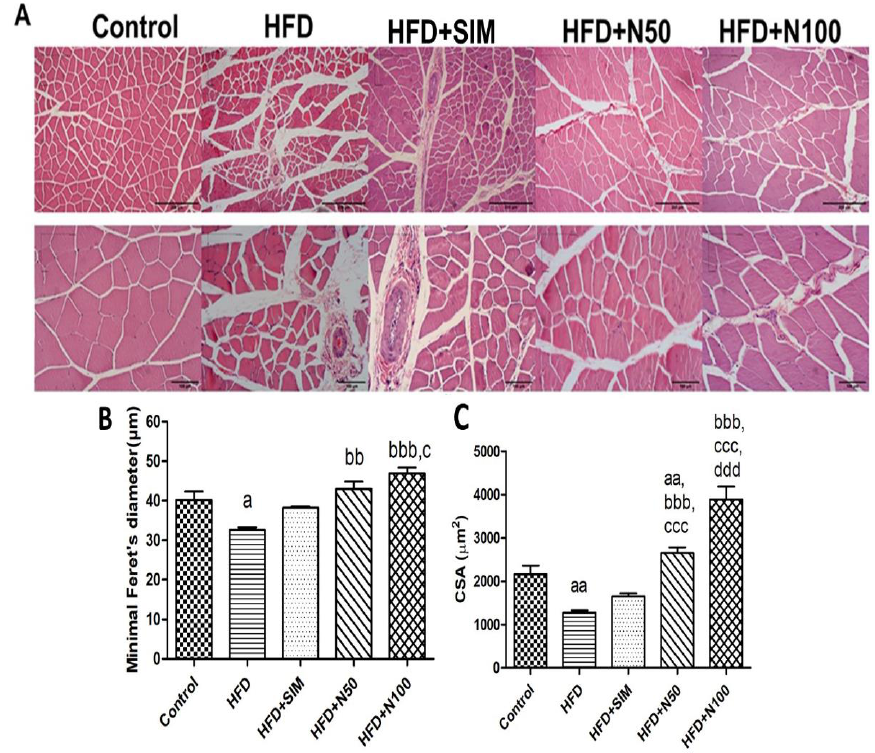
Figure 5. The effect of naringin on the morphology of high-fat-diet-fed rats. Representative H&E- stained images of the quadriceps were shown at 40X (scale bar = 200 μm) and 100X magnification (scale bar = 100 μm) ( A ). Minimal Feret’s diamete rs (fibre diameter) ( B ) and cross-section area (fibre area) ( C ) were calculated. Results are shown as mean ± SEM for 5 to 7 rats per group. a p < 0.05, and aa p < 0.01 vs. the control group; bb p < 0.01, and bbb p < 0.001 vs. the HFD group; c p < 0.05, and ccc p < 0.001 vs. the HFD + SIM group; and ddd p < 0.01 vs. the HFD + N50 group.